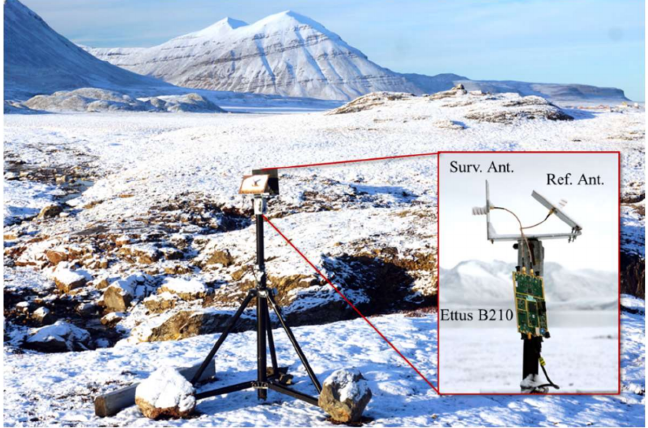
Figure 17. Setup of the experiment conducted in Spitsbergen, Norway. The system is fixed on the same position for a period of 12 days to show its stability and repeatability.